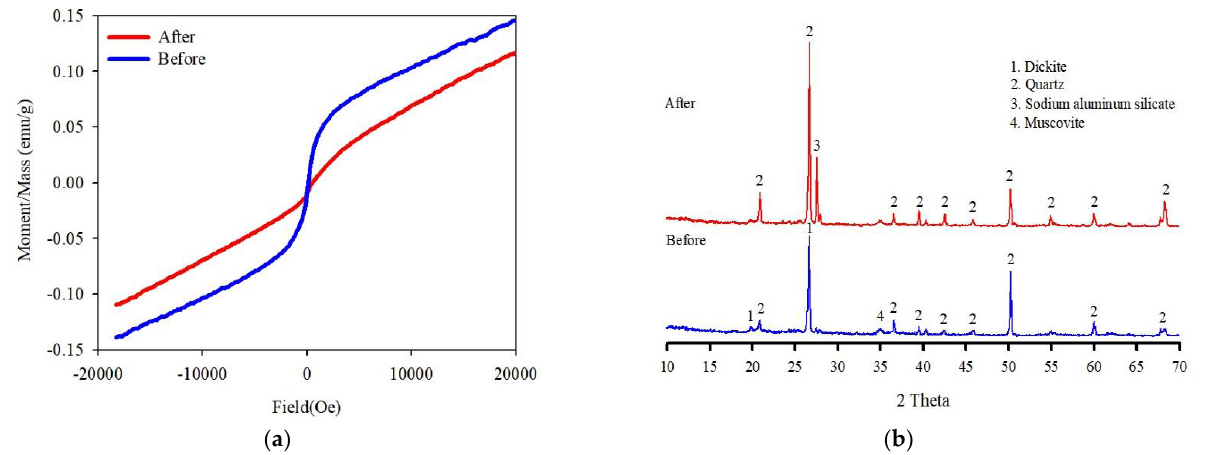
Figure 8. ( a ) Hysteresis loop and ( b ) XRD patterns of the original soil and treated soil. The obtained infrared spectroscopy spectra of the soil showed the characteristic bands